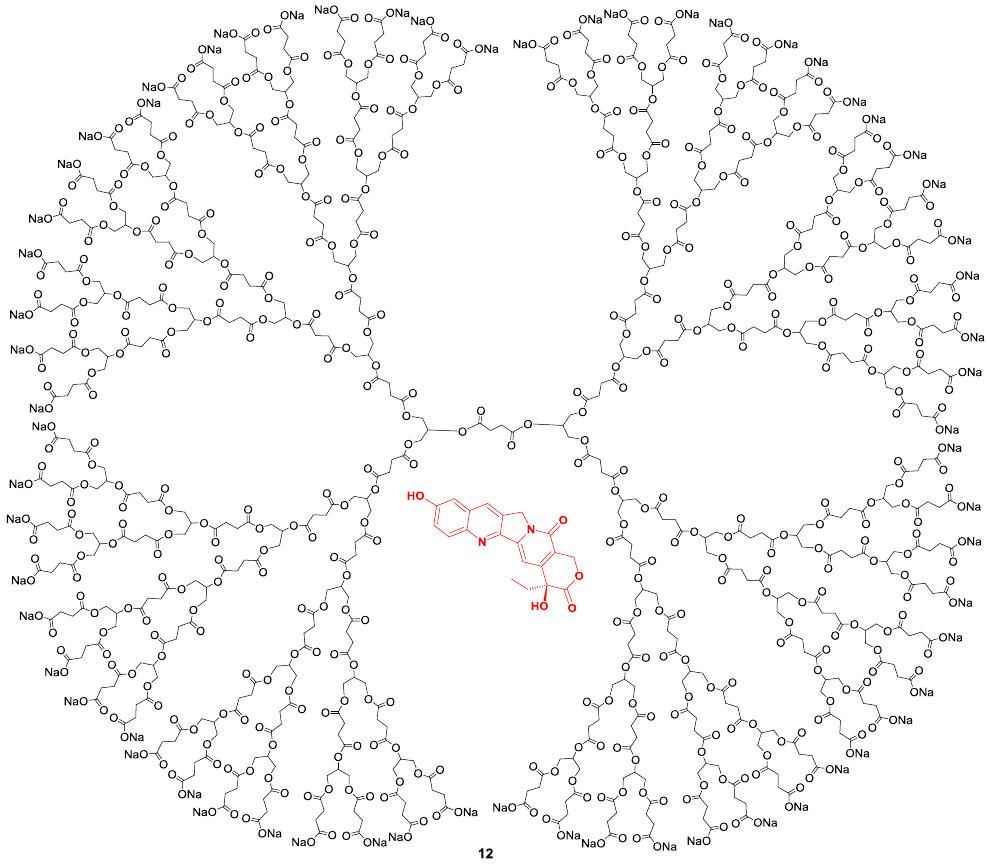
Figure 3. Encapsulation of antitumor camptothecin